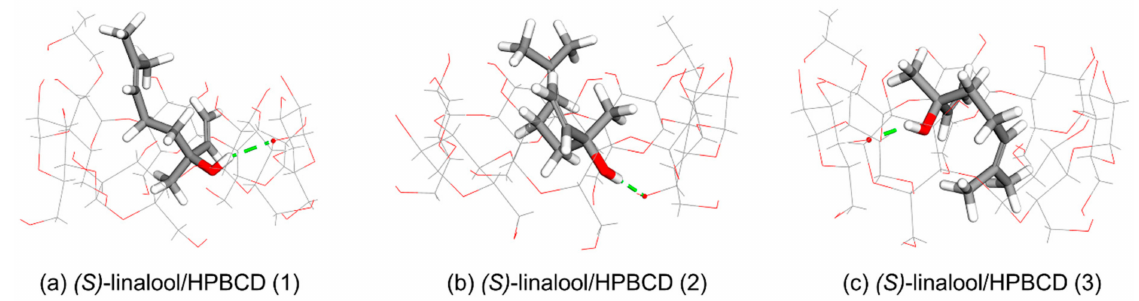
Figure 11. Energy-minimized structure of the 1:1 ( S )-linalool/HPBCD complexes from three clusters using PM7 method. HPBCD is presented as a line model. The linalool molecule is presented as a stick model. The green dashed line refers to hydrogen